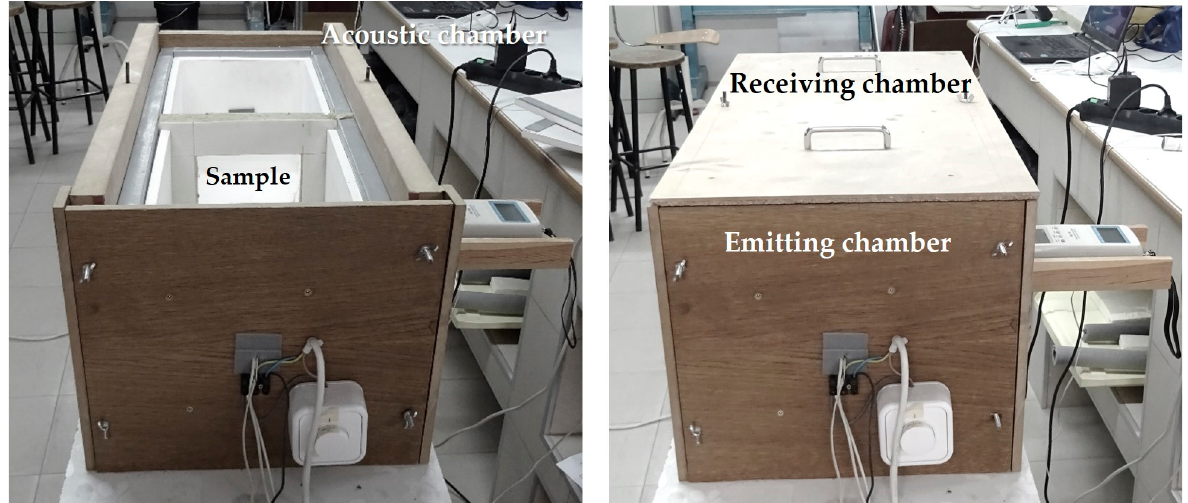
Figure 2. Acoustic reduced-scale chamber set-up for measuring sound insulation. A background noise of 50 dBA was recorded at the external sound-level meter and 40 dBA inside the closed acoustic chamber. Each mortar sample was measured every 15 s for 60 s on both sides: one corresponding to the side manufactured on the outer side of the mold, designated rough side (RG), and the other casted against the mold, denominated smooth side (SM). Acoustic pressure in dBA was measured for each frequency range between 100–5000 Hz, comparing measurements with and without mortar samples,